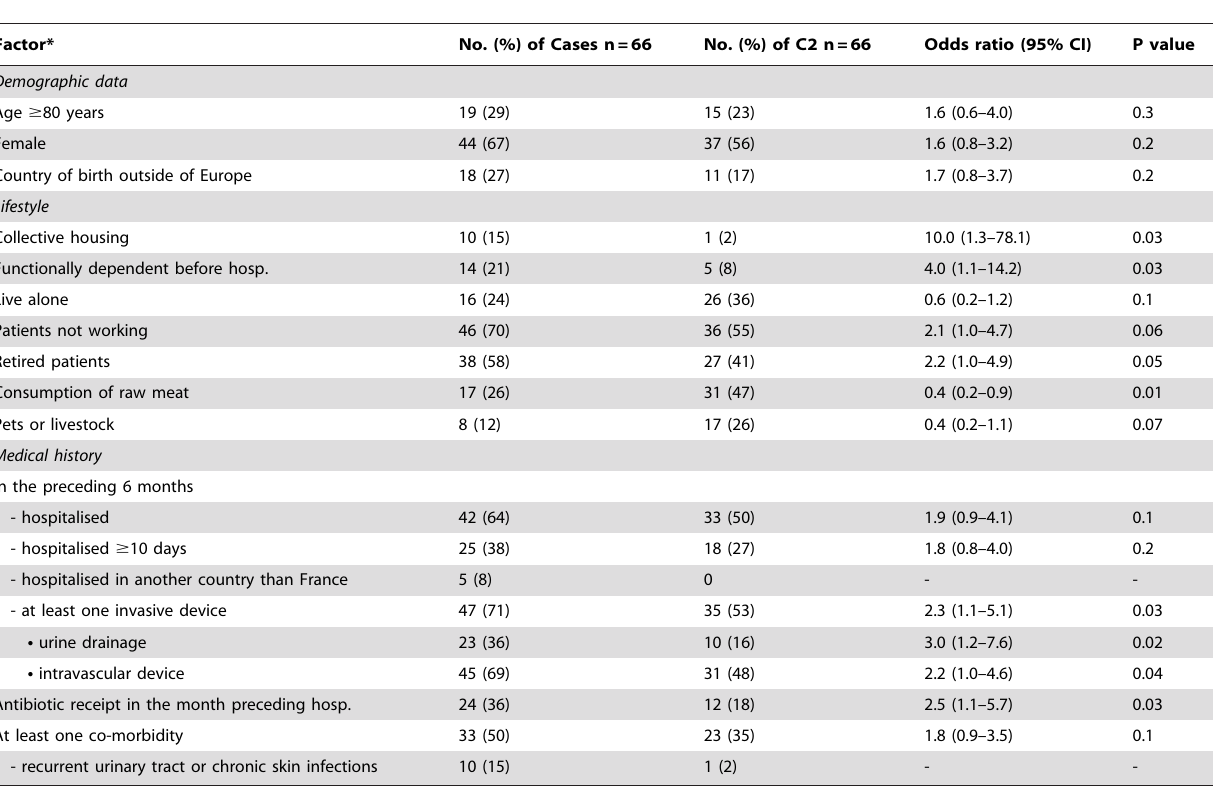
Table 6. Univariate analysis of factors associated with a CTX-M producing E. coli clinical isolate within the first 48 h of hospitalisation in subpopulations of cases (patients with a CTX-M producing E. coli isolate) and controls (C2 : patients with negative clinical samples).